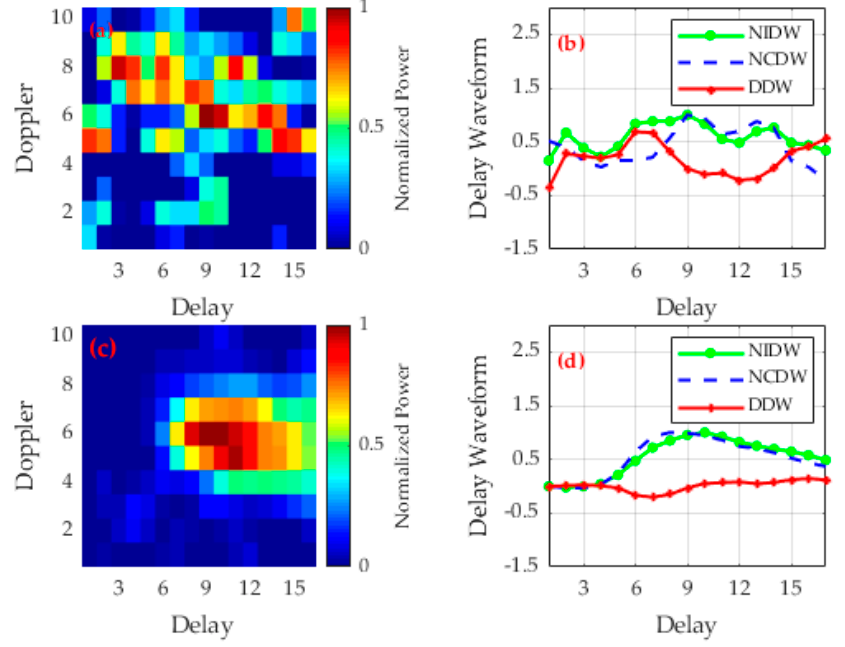
Figure 5. DDMs with large noise and small noise and corresponding delay waveforms. ( a ) DDM with large noise (SNR = 0.5207 dB), ( b ) delay waveforms with large noise, ( c ) DDM with small noise (SNR = 2.6943 dB), ( d ) delay waveforms with small noise.